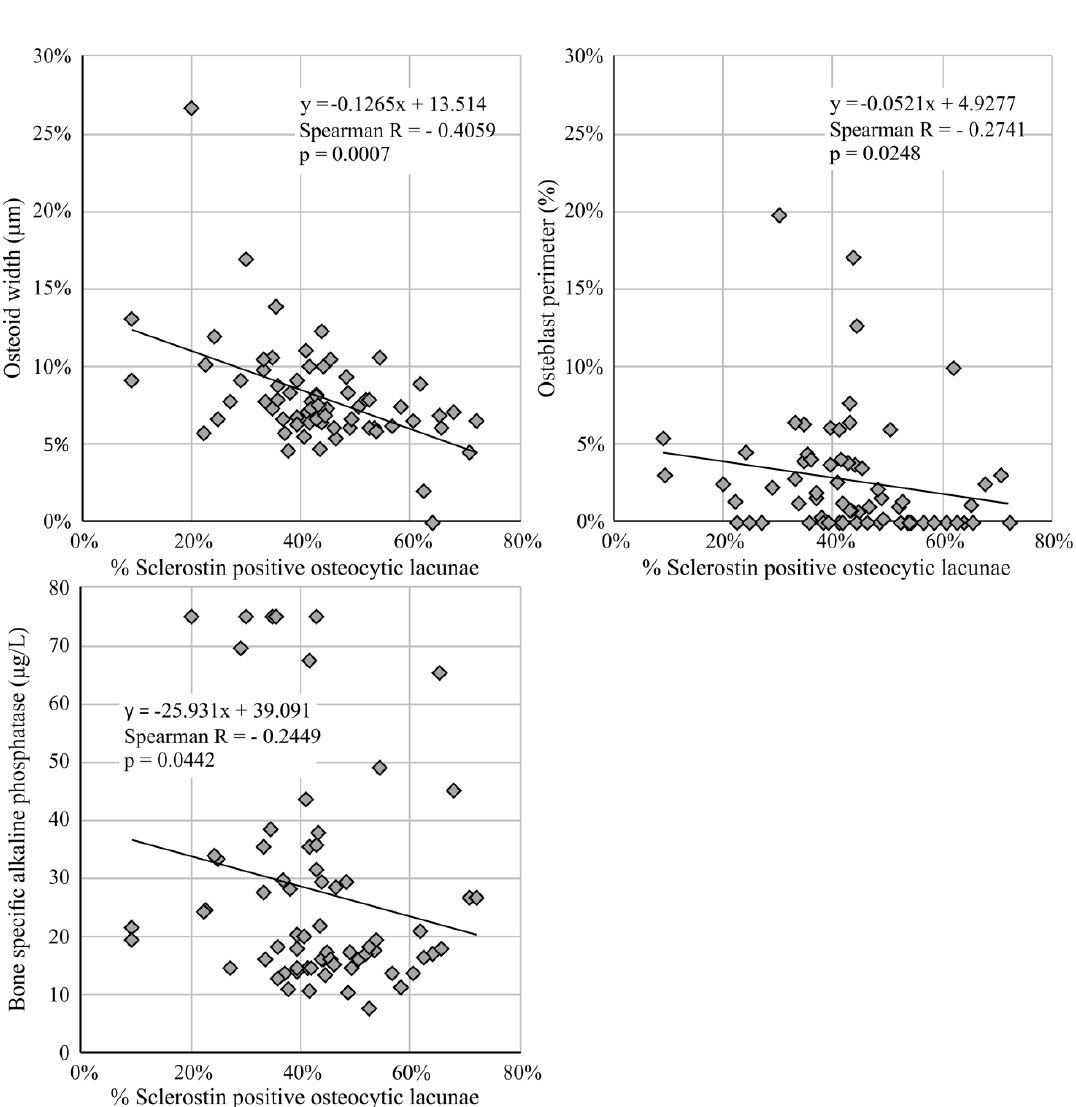
Figure 1. Negative correlation between the percentage of sclerostin-positive osteocytic lacunae and the osteoid area, osteoid perimeter, osteoid width, osteoblast perimeter, and bone-specific alkaline phosphatase.